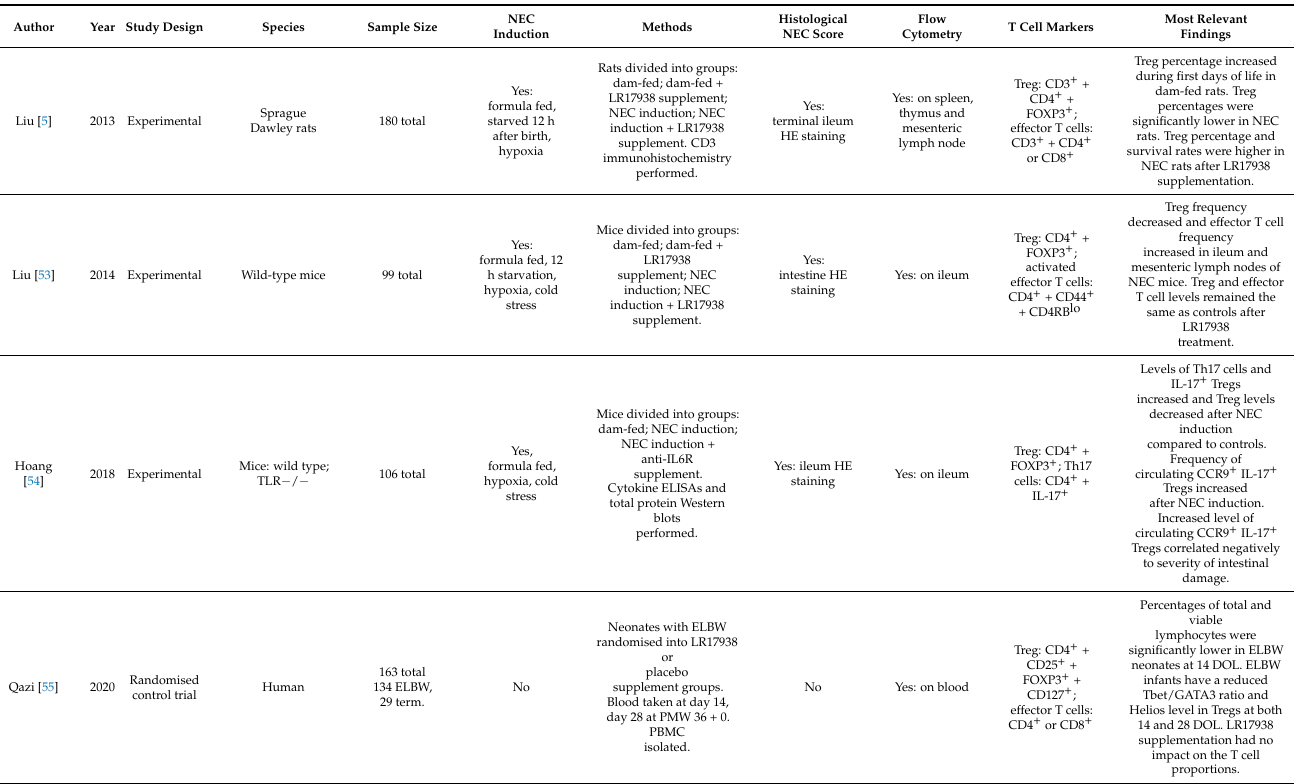
Table 4. Characteristics and main findings of the included LR19738-related